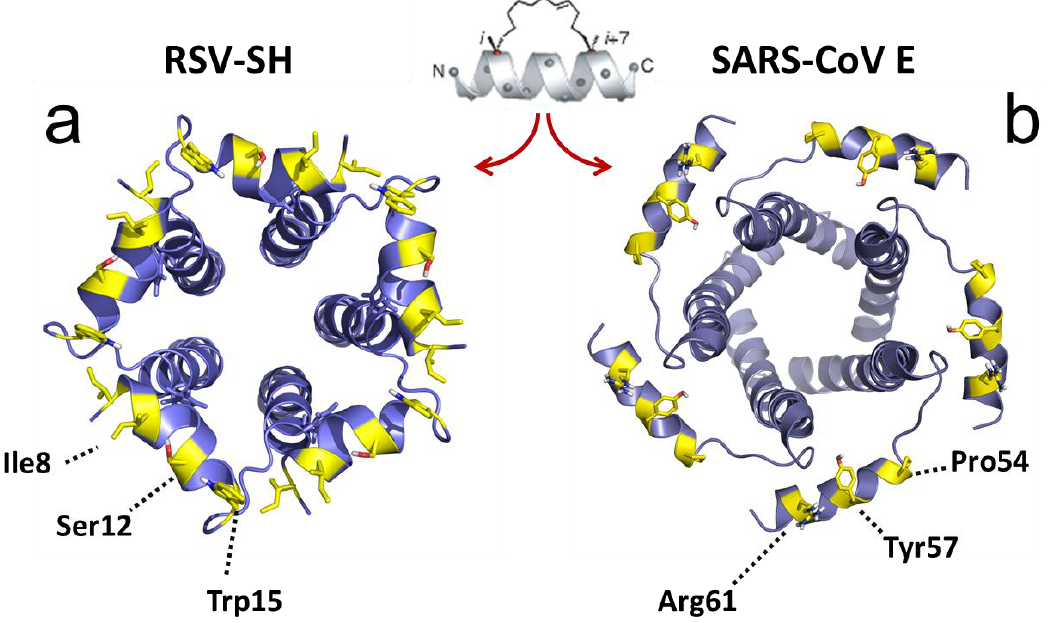
Figure 7. RSV SH and SARS-CoV E protein channels. ( a ) RSV SH protein channel and ( b ) SARS-CoV E protein channel, viewed from the cytoplasmic side [126,148]. The residues exposed to the cytoplasmic side (yellow) may be actively involved in protein-protein interactions and these cytoplasmic α -helices can be used as templates for stapled α -helical